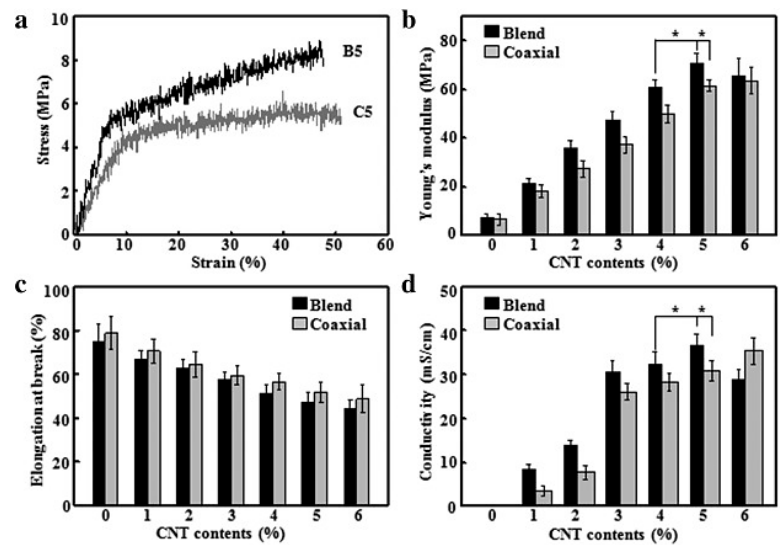
Figure 5. ( a ) Typical stress–strain curves of blend and coaxially electrospun fibrous mats containing 5% of carbon nanotubes (CNTs). ( b ) Young’s modulus, ( c ) elongation at break and ( d ) conductivity of blend and coaxially electrospun fibrous mats containing different amounts of CNTs. Reprinted from [130] with permission from Elsevier.